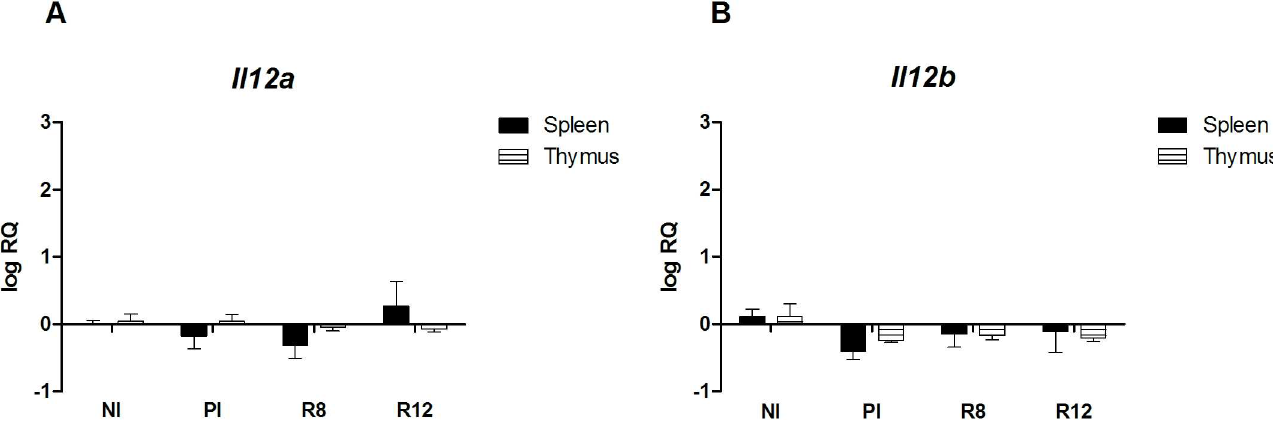
Fig 5. Effect of Fasciola hepatica reinfection on the Il12a and Il12b expression from the spleen and thymus. A) Spleen.B) Thymus. Group NI: non-infected controls; Group PI: rats receiveda single infectiondose; Group R8: infected and reinfected rats at 8 weeks after primary infection; Group R12: infected and reinfected rats at 12 weeks after primary infection. (A) Il12a expression. (B) Il12b expression. Bars represent mean ± SE values. No statistically significantdifferenceswere found (P < 0.05, Mann-Whitney non-parametric test).